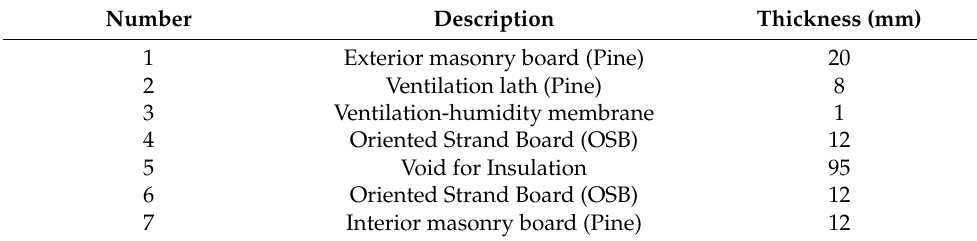
Table 3. Masonry layers used (thickness).